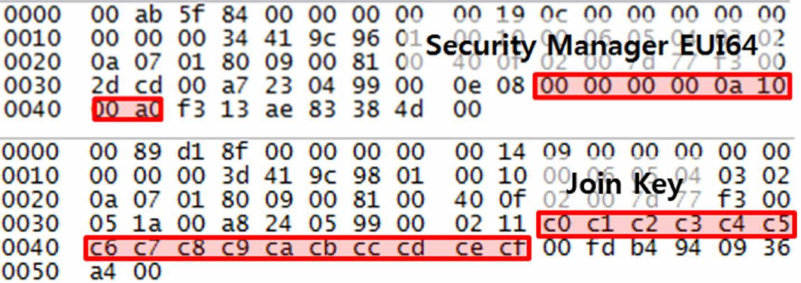
Figure 5. Captured provisioning packet of EUI-64 address of the security manager and the join